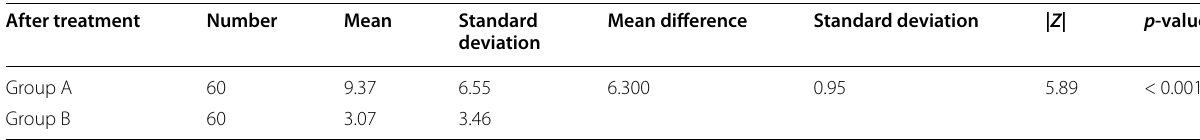
Table 3 Comparison between mean SNOT-22 of group A and group B